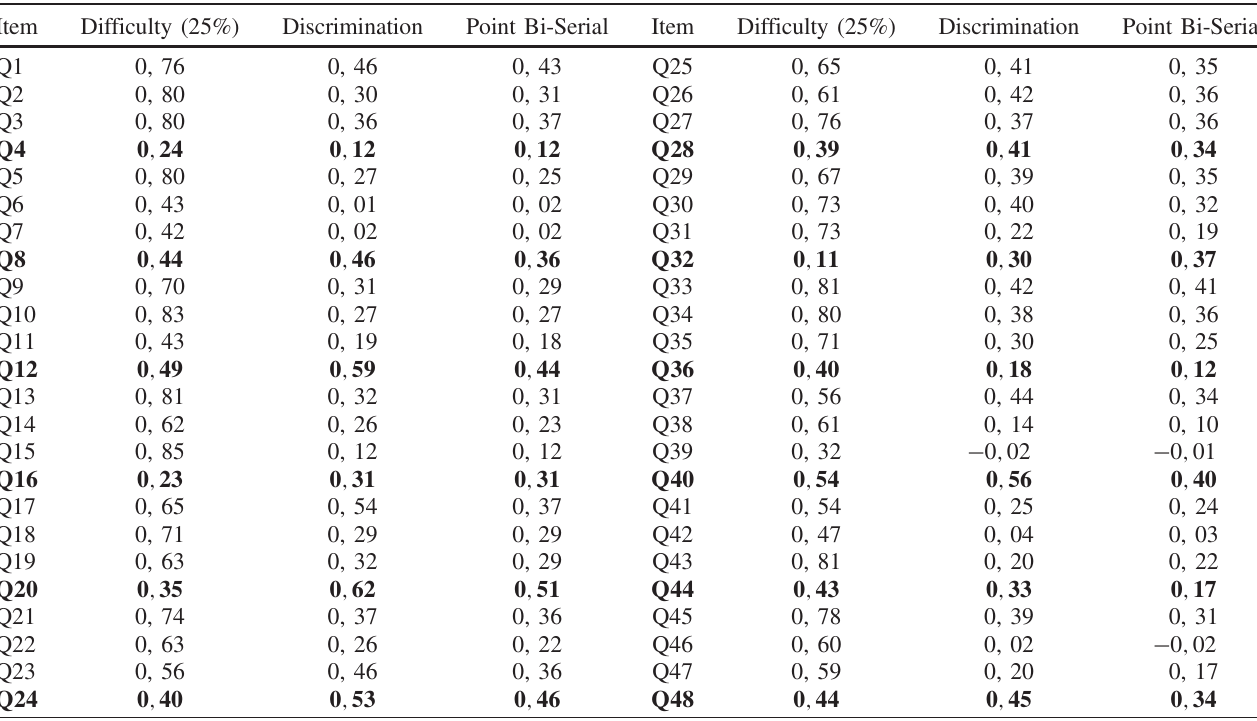
TABLE III. Psychometric indices of the questionnaire. Multiple choice questions are indicated in bold face.